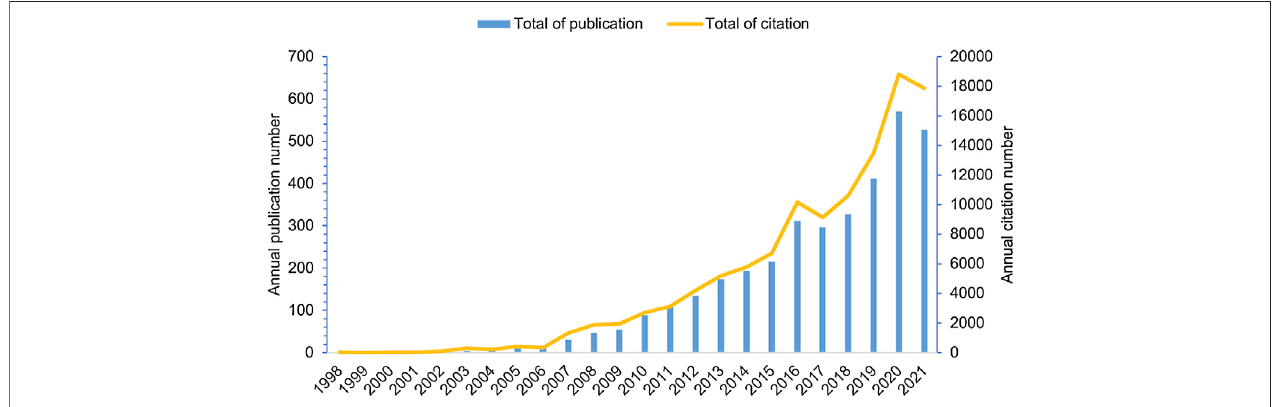
FIGURE 1 | Distribution of annual publications and citations on in fl ammatory tumor microenvironment.